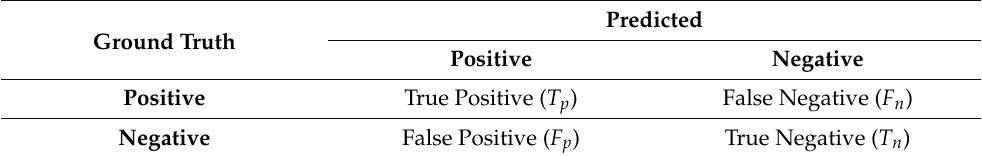
Table 2. Definition relationships between predicted and true values. Ground Truth